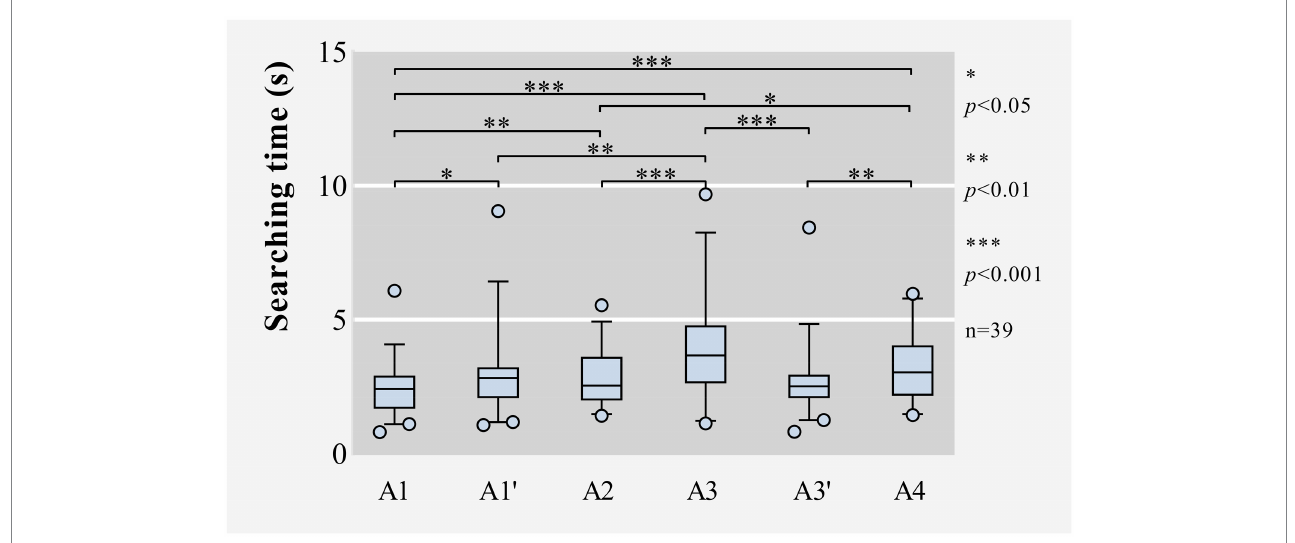
FIGURE 4 Box plots of raw data for the searching time in rectangular layout.